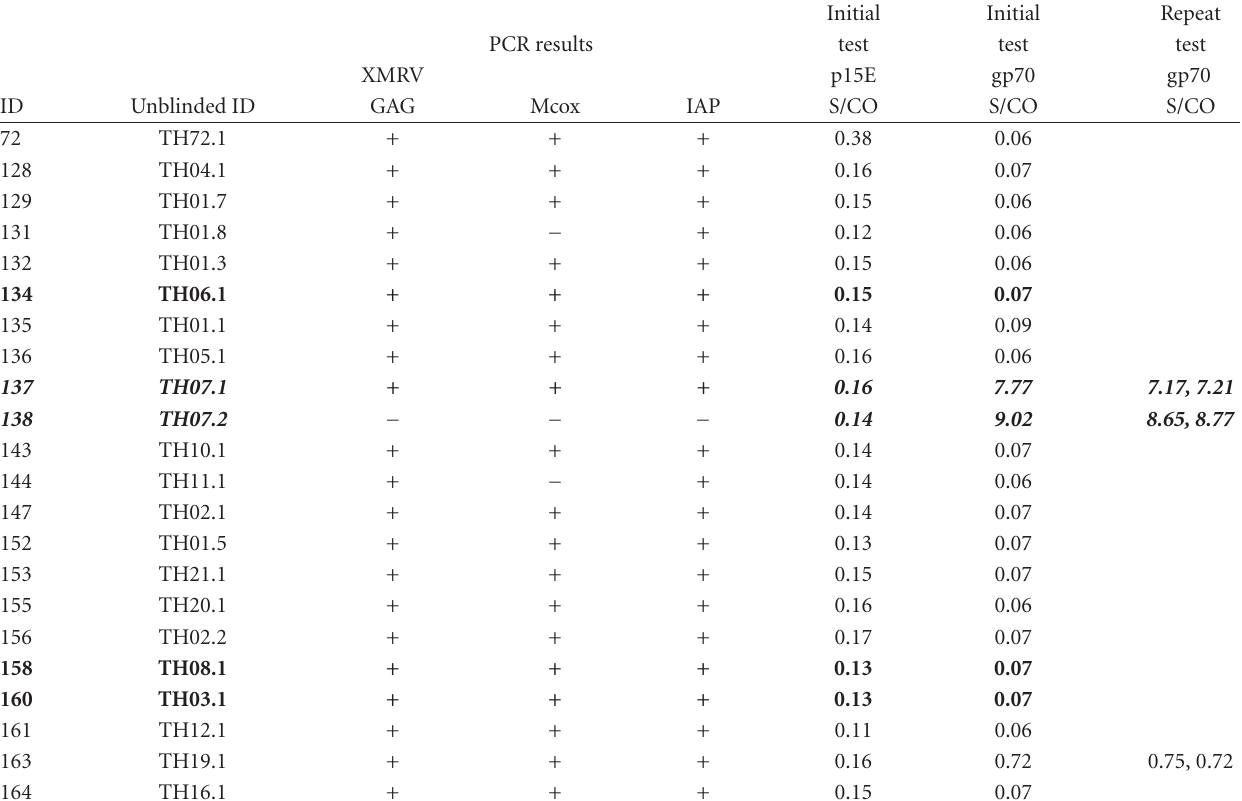
Table 1: Results summary for XMRV positive PCR samples. All samples that tested positive for XMRV gag sequence in original study [17], as well as the two samples that reacted with the gp70 CMIA, are displayed. Bolded samples showed the VP42 gag sequence but did not react with the CMIAs. The italic data shows the two samples that were reactive in the gp70 CMIA. CMIA values less than one are considered